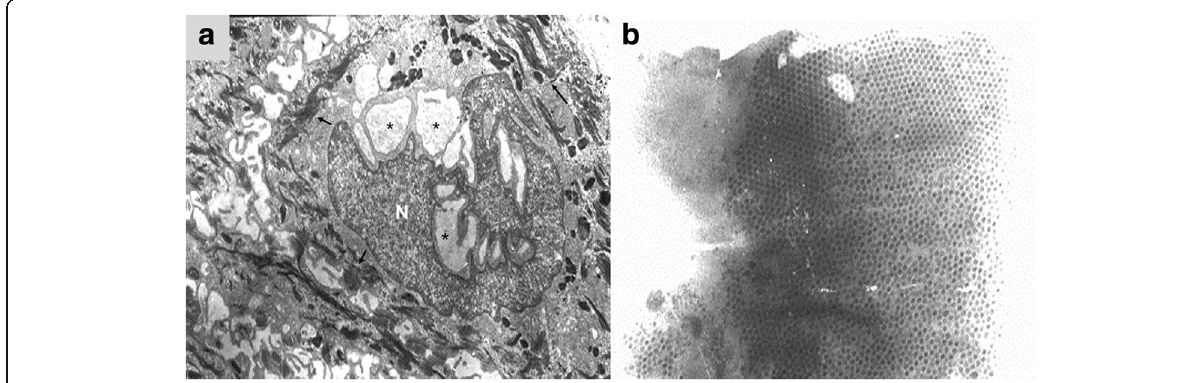
Fig. 4 Transmission electron microscopy of epidermodysplasia verruciform lesion. a Keratinocyte with irregular-shaped nucleus (N), dilated endoplasmic reticulum cisternae (*) and tonofilaments grouped (arrows) at cytoplasm periphery (original magnification 10,000x) b Typical viral particles with crystalline arrangement (original magnification